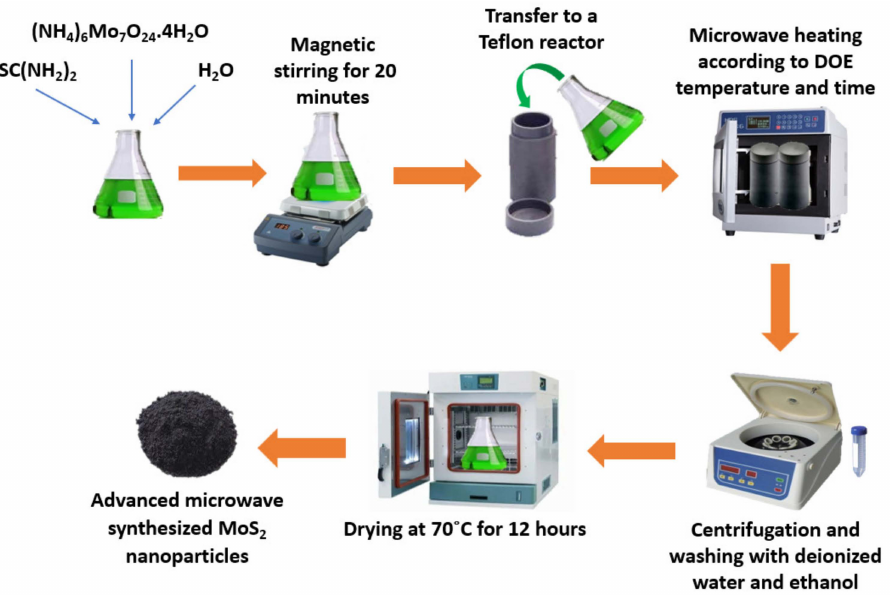
Figure 7. Schematic diagram of microwave-synthesized molybdenum disulfide nanoparticles. Adapted from